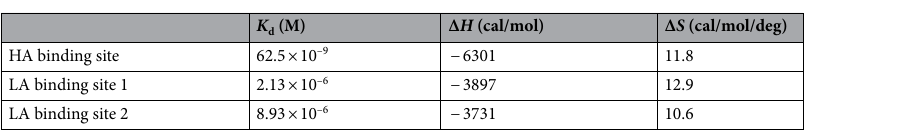
Table 1. Thermodynamic parameters for the best fit of ITC binding curve by the “Sequential Binding Sites”